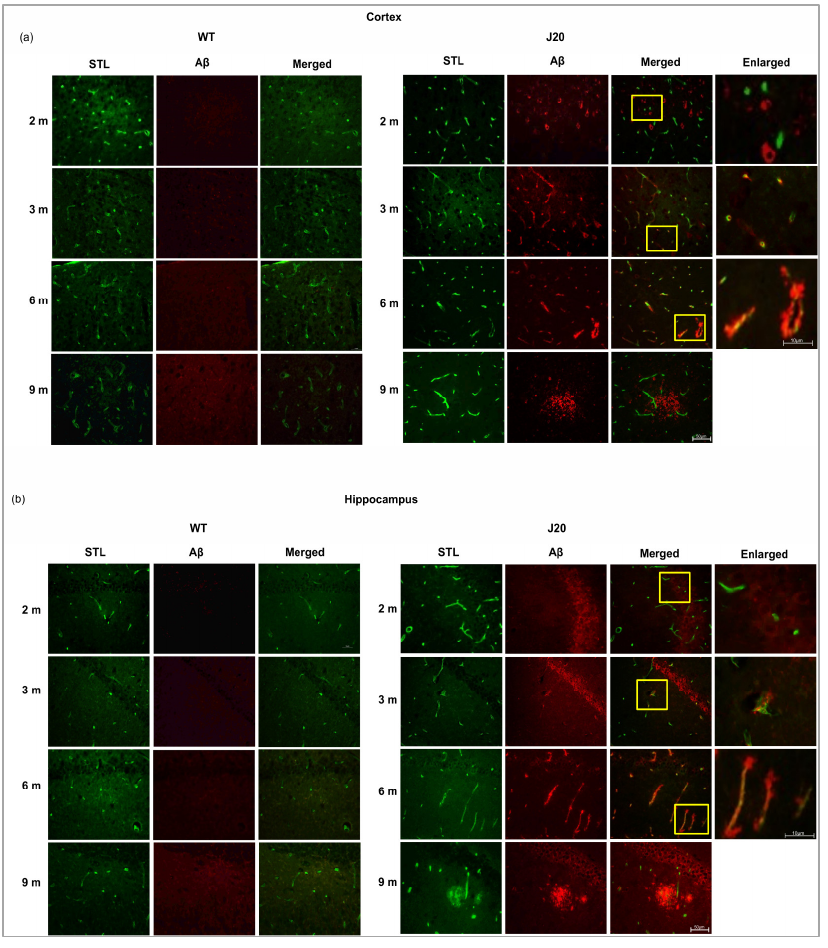
Figure 3. Double immunofluorescence staining of Aβ peptide and FITC conjugated solanum tuberosum in the ( a ) cortex, and the ( b ) hippocampus of both WT and J20 mice brain at age 2, 3, 6, and 9 months. Aβ immunoreactivity was positive for both neuronal and endothelial cells between 3 and 6 months, as contrasted to 2 months when Aβ peptide was solely positive for neuron cells. All yellow boxed areas were magnified. At 2 months, only neurons positive for Aβ, Aβ around the vessel at 3 months and at 6 months increased Aβ deposits around the vessel. At 9 months of age, extravascular Aβ deposition in parenchyma. M indicates month. Scale bar = 50 µm.